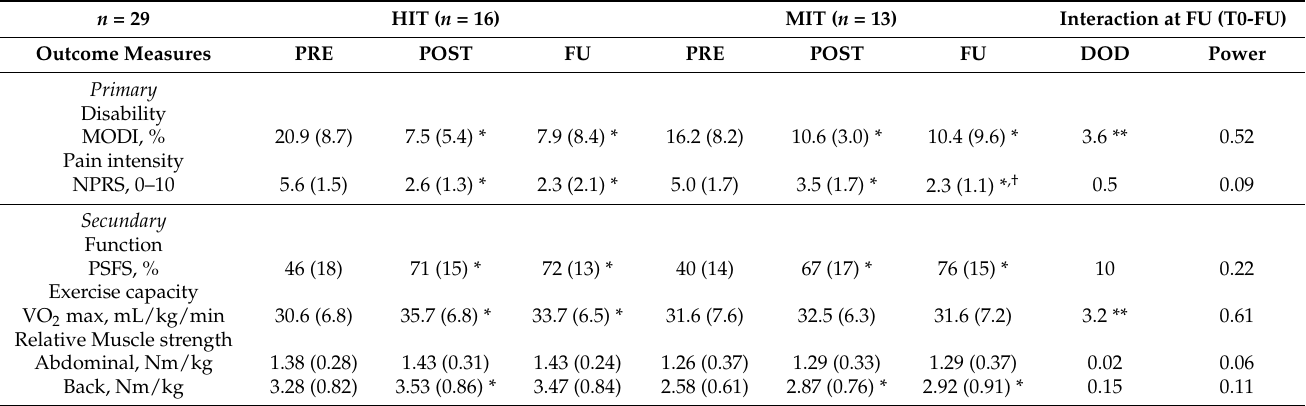
Values in HIT and MIT are reported as mean (standard deviation) and represent results of the Numeric Pain Rating Scale (NPRS), Modified Oswestry Disability Index (MODI), Patient-Specific Functioning Scale (PSFS), a cardiopulmonary exercise capacity test, and a maximum isometric muscle strength test of the abdominals and back, before (PRE) and after (POST) 24 sessions of high intensity training (HIT, 100%